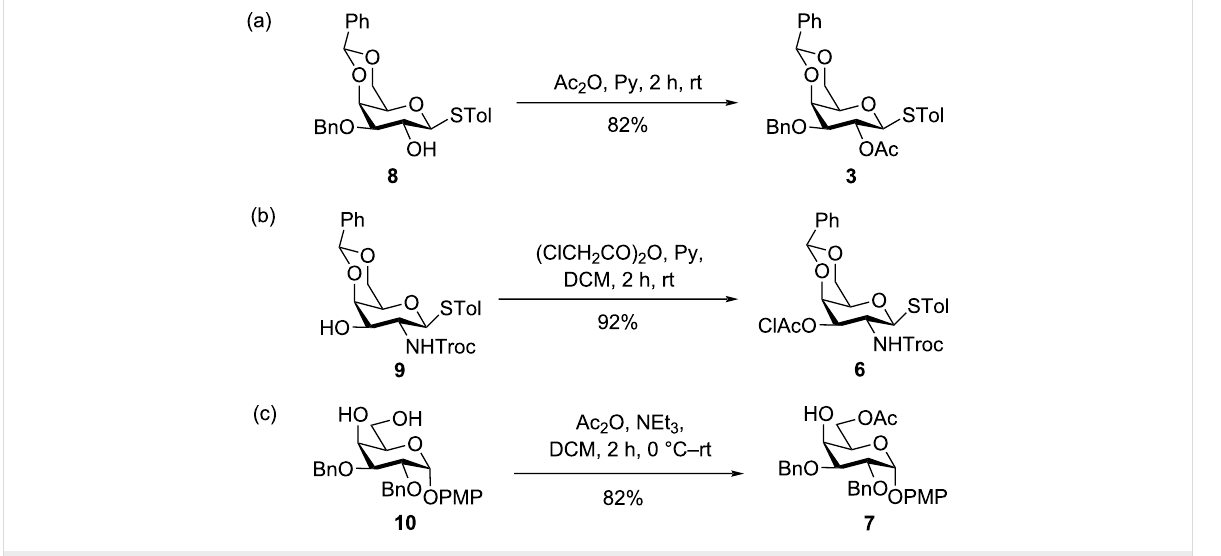
Scheme 2: Synthesis of the monosaccharide building blocks 3 , 6 , and 7